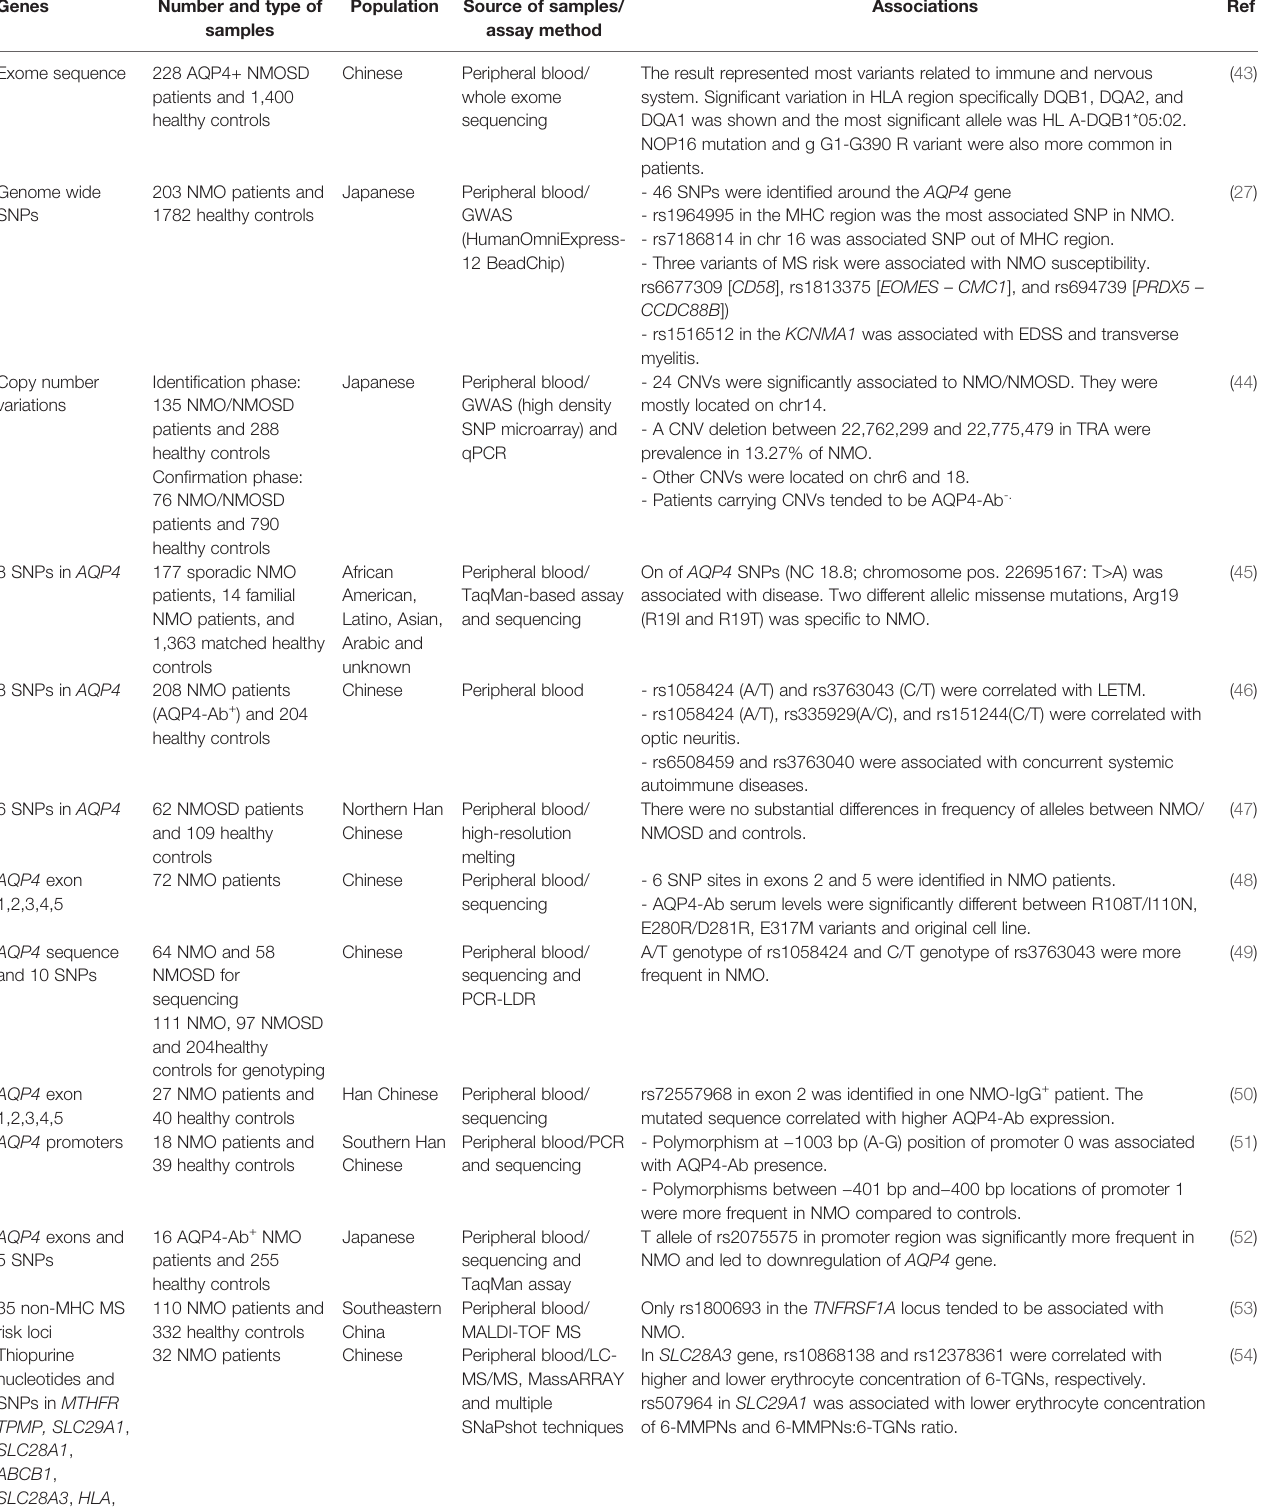
TABLE 3 | Genomic studies in neuromyelitis